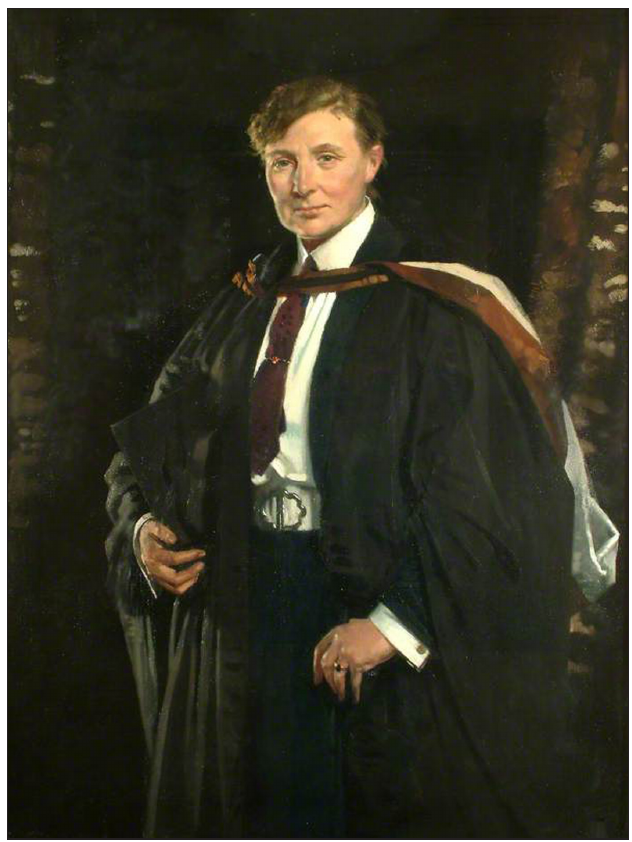
Fig. 10 : William Orpen, Miss Ellen Charlotte Higgins , 1926, oil on canvas, 125.7 × 101.6 cm, Royal Holloway, University of London,